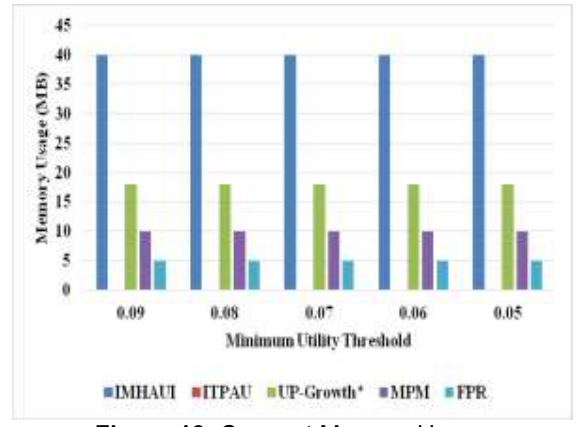
Figure 13. Connect Memory